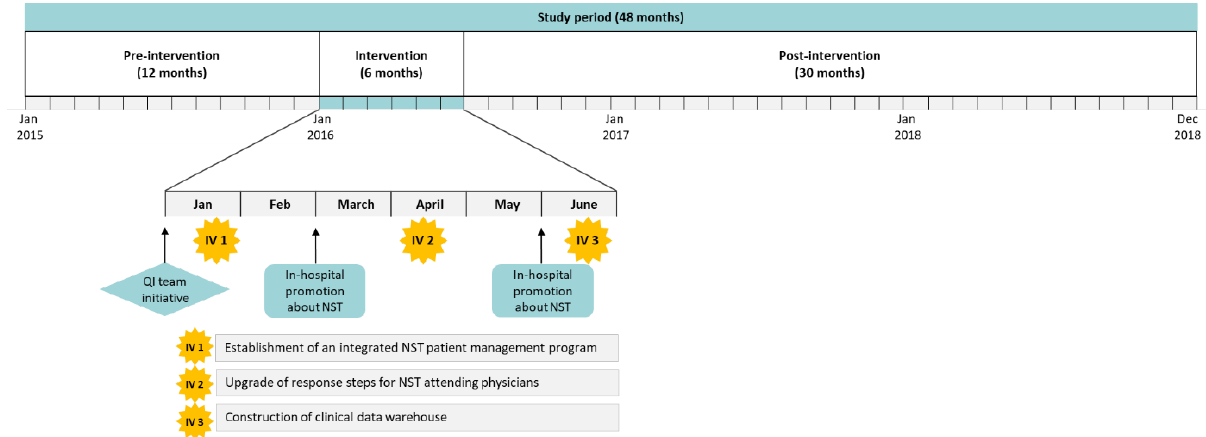
Figure 1. Nutrition support process by the multidisciplinary nutrition support team (NST) at Seoul National University Bundang Hospital: Intervention ( IV 1 ), NST patient management program establishment; ( IV 2 ) upgrade of NST attending physicians’ response steps; ( IV 3 ) construction of clinical data